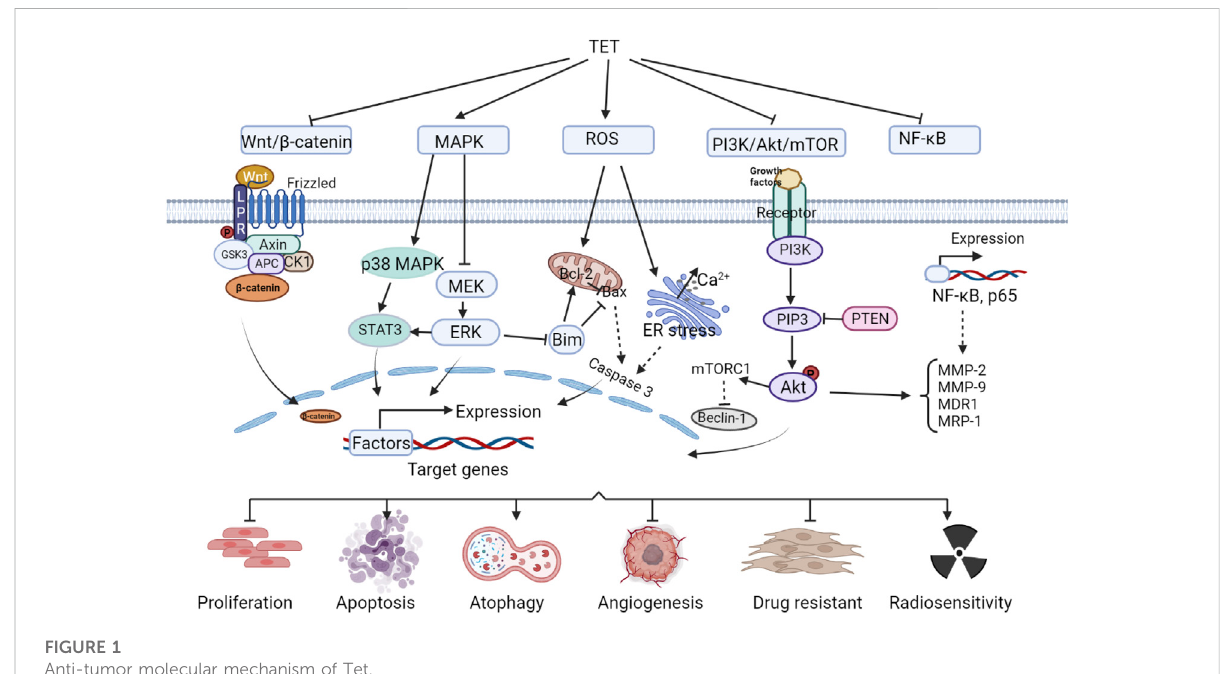
Anti-tumor molecular mechanism of